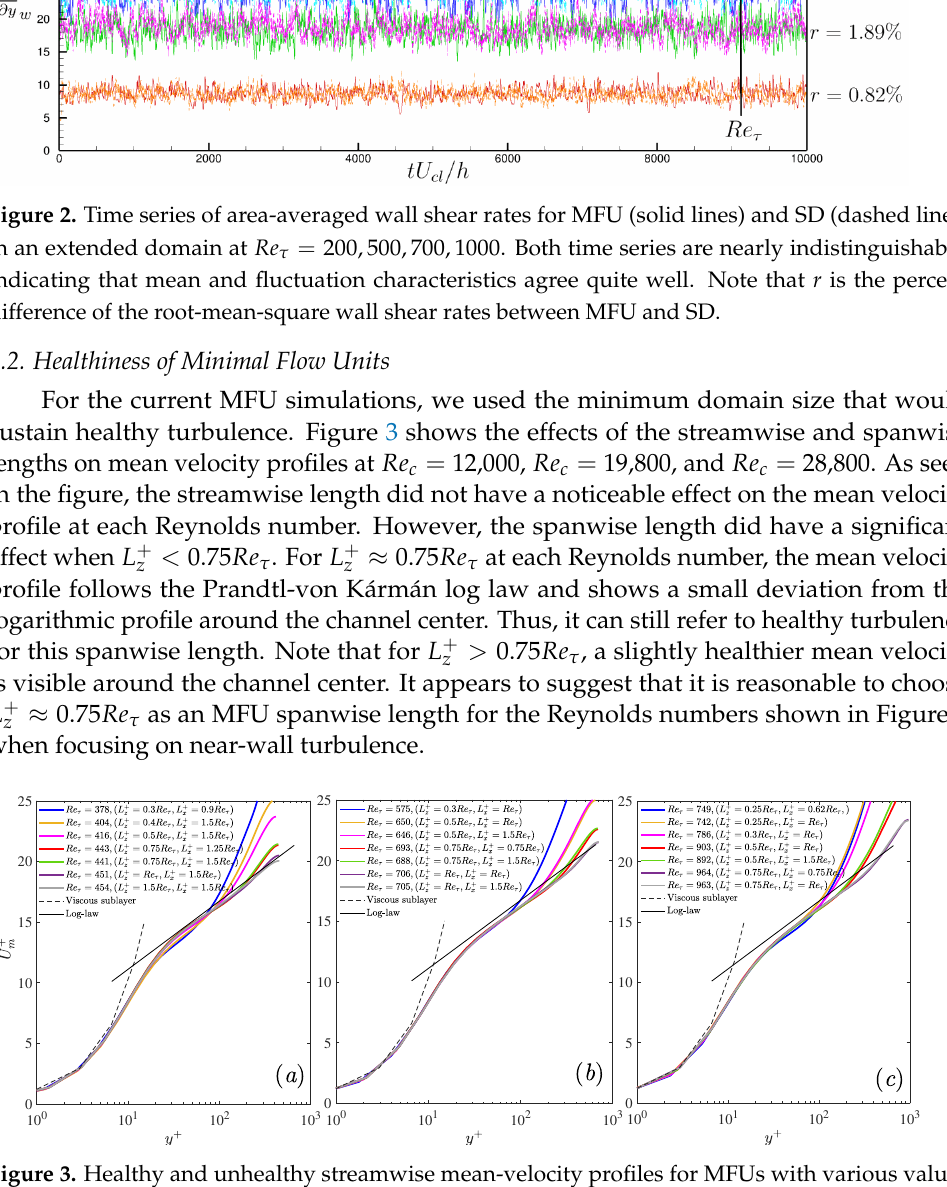
Figure 3. Healthy and unhealthy streamwise mean-velocity profiles for MFUs with various values of L + x and L + z at ( a ) Re c = 12,000, ( b ) Re c = 19,800, and ( c ) Re c = 28,800. For these Reynolds numbers, when L + z < 0.75 Re τ , the mean velocity profiles appear to become unhealthy in regard to the logarithmic